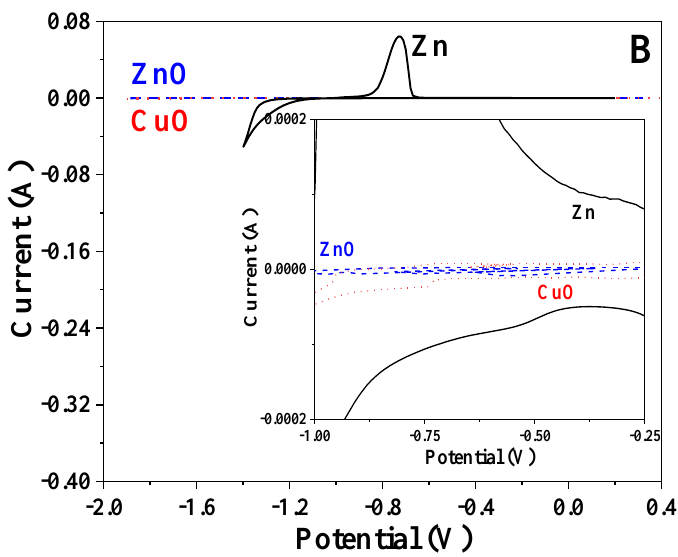
Figure 8. Cyclic voltammetry measurements of ZnO/Zn, CuO/Zn, and ordinary Zn: ( A ) Inset – cathodic process; ( B ) Inset – anodic process The anodic branches of both CVA curves confirm the presence of thin layers (ZnO or CuO, respectively), which are dissolved during the anodic polarization—Figure 8B